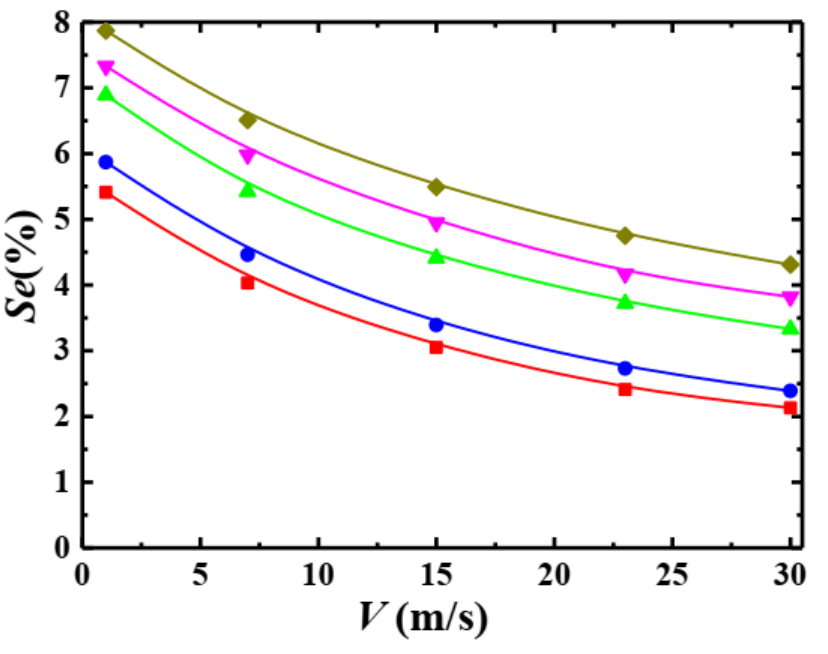
Figure 9. Relationship between Se and V for different particle diameters ( α s = 5%, m s = 15 t/h). d p : (cid:4) : 50 µ m; • : 100 µ m; (cid:78) : 500 µ m; (cid:72) : 750 µ m; (cid:7) : 1000 µ